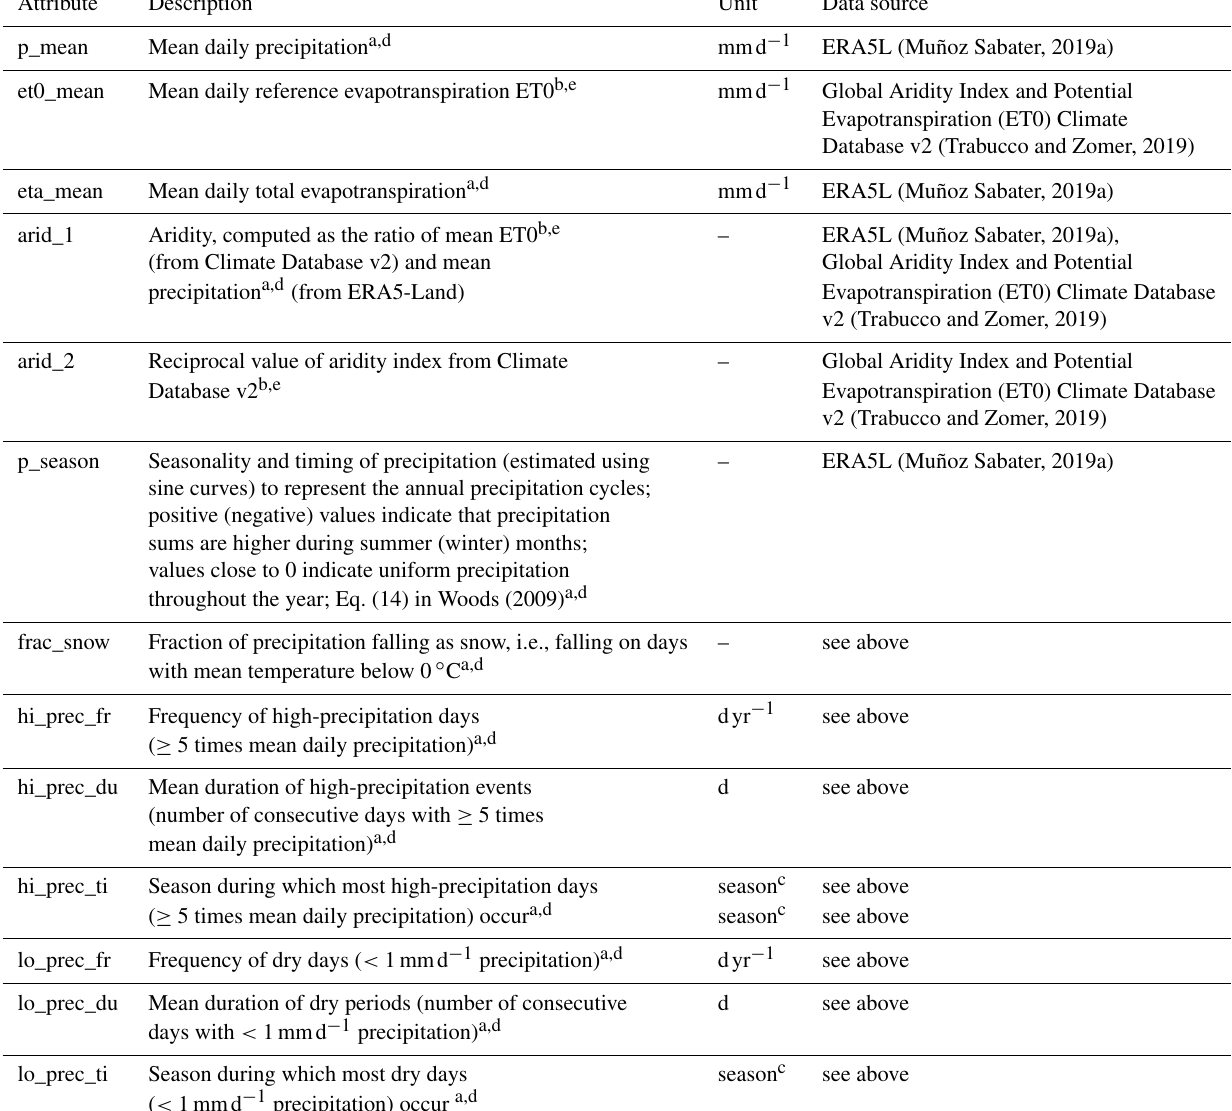
Table A4. Climatic